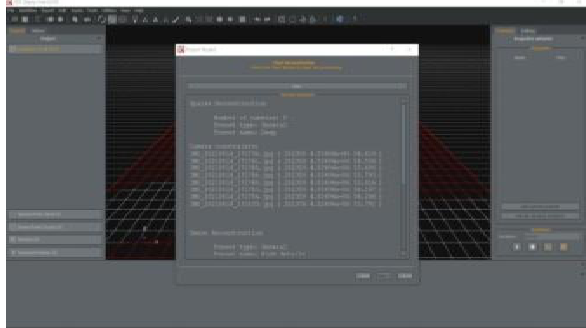
Figure 6. The Progress of